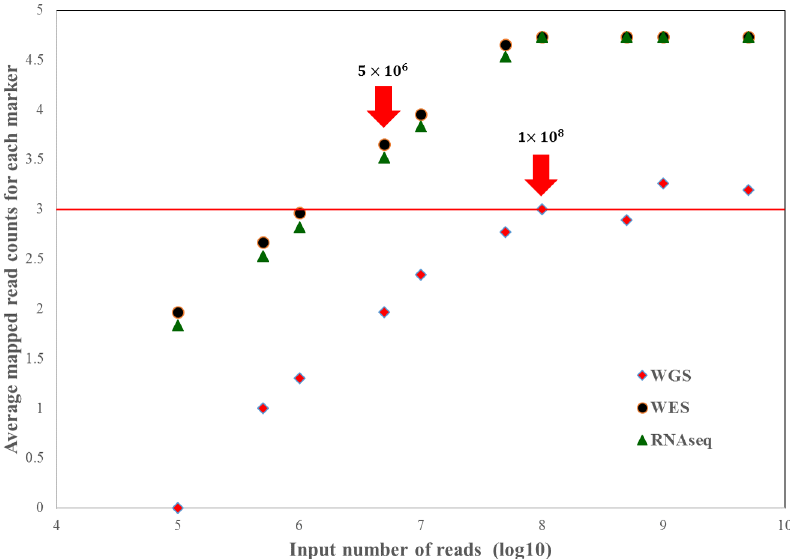
Fig 2. Average read counts for each markerby input number of million sequence reads (log10) for human (hg38) datasets. Red arrows indicate minimumread counts: 5 million (5 × 10 6 ) reads for whole-exome sequencing and RNA sequencing and 100 million(1 × 10 8 ) reads for whole-genome sequencing. The red horizontal line denotes the minimumaverageread counts of sex-specific marker sequences.